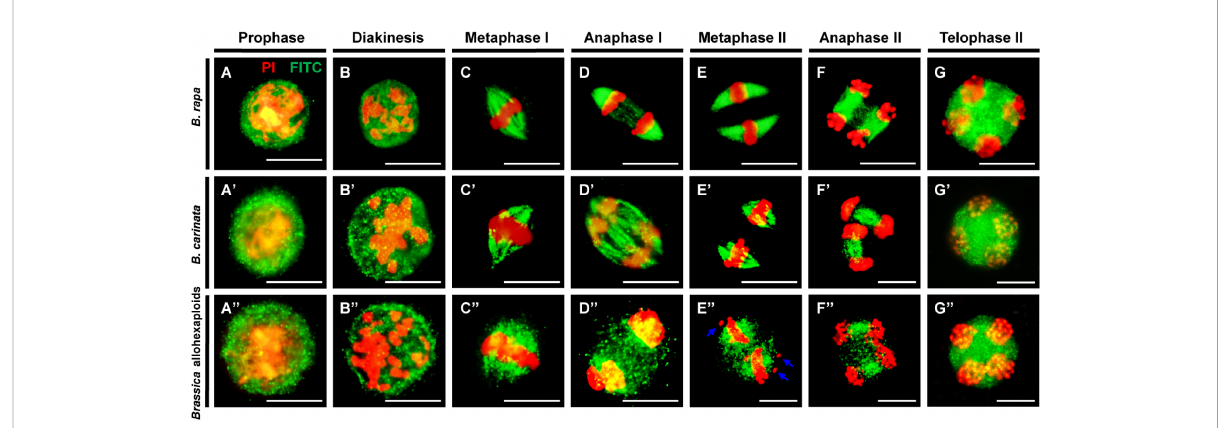
FIGURE 4 Spindle organization during meiosis in B. rapa , B. carinata and Brassica allohexaploids. (A – G) Normal spindle organization and chromosome behavior observed in pollen mother cells (PMCs) of B rapa . ( A ’– G ’ ) Normal spindle organization and chromosome behavior observed in PMCs of B carinata . (A ”– G ” ) Abnormal spindle organization and chromosome behavior observed in PMCs of the Brassica allohexaploids. Microtubules and chromosomes are colored in green and red, respectively. Blue arrows indicate lagging chromosomes. Bars = 10